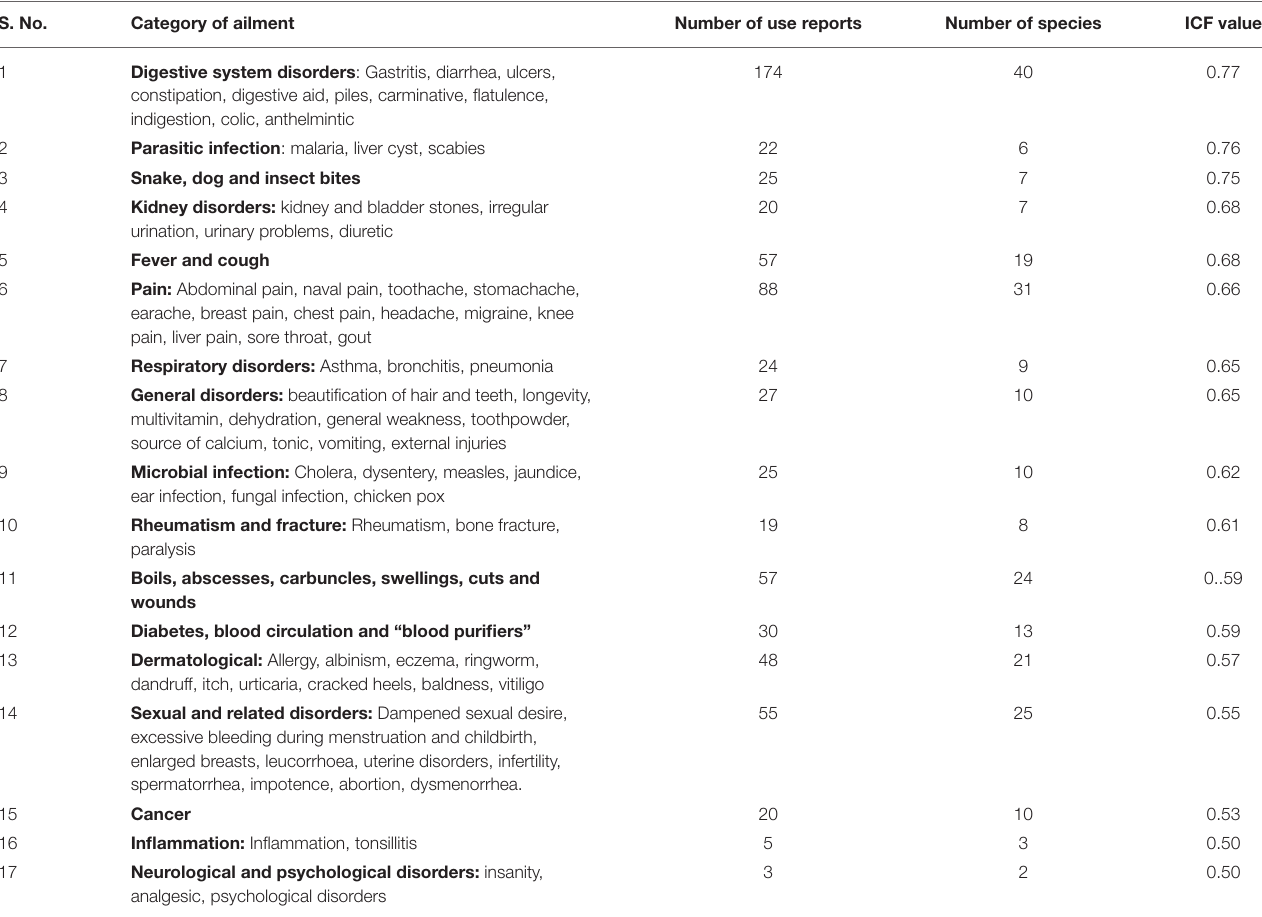
TABLE 3 | Informant Consensus Factor (ICF) by category of ailment within the present study. S.